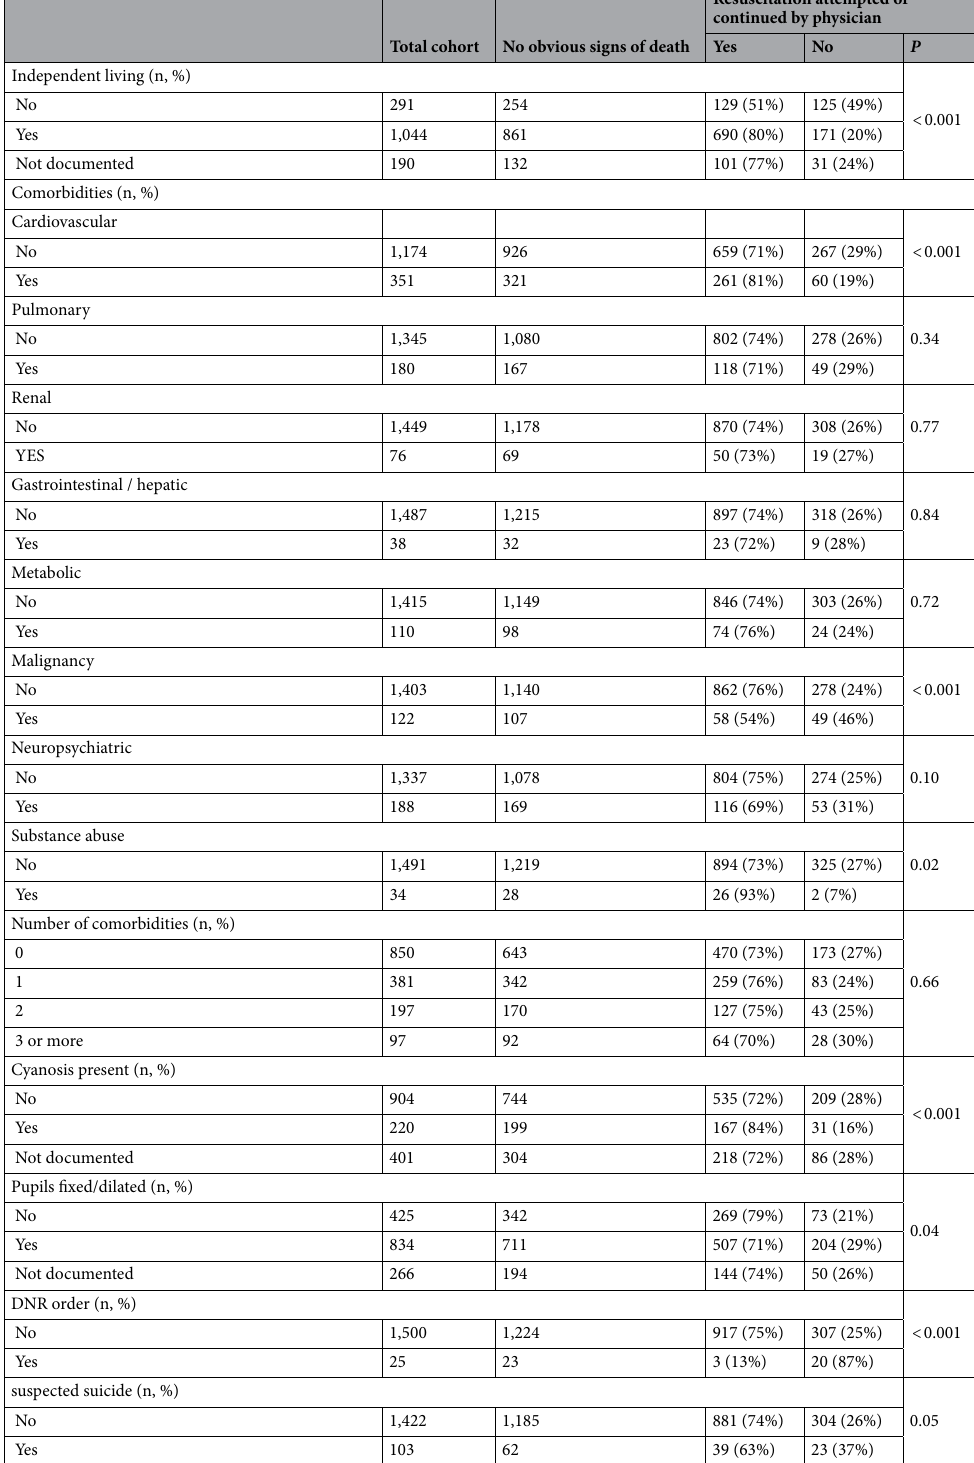
Table 1. Unadjusted system data, patient core data and supplementary patient data according to the Utstein- style in the total patient cohort, in patients without obvious signs of death, in patients in whom resuscitation was either attempted or continued by physicians and in patients in whom it was not; P -values for comparisons between the latter two groups using Kruskal–Wallis-test or Fisher’s exact test, as appropriate. DNR do